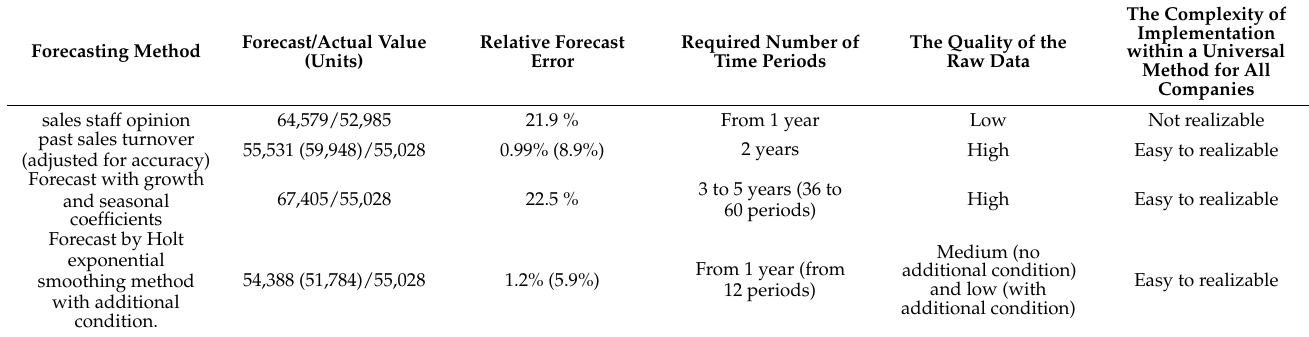
Table 10. Final evaluations of different forecasting